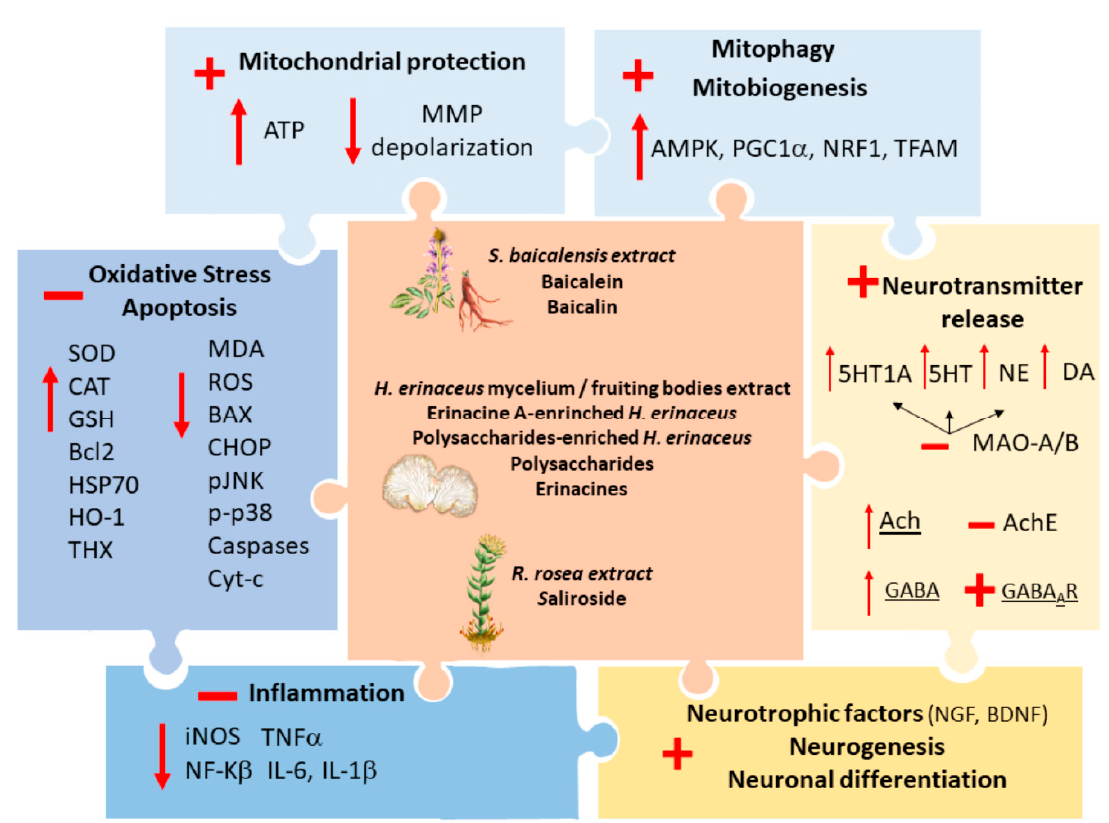
Figure 3. Mechanisms underlying the neuroprotective effects of S. baicalensis, H. erinaceus and R. rosea